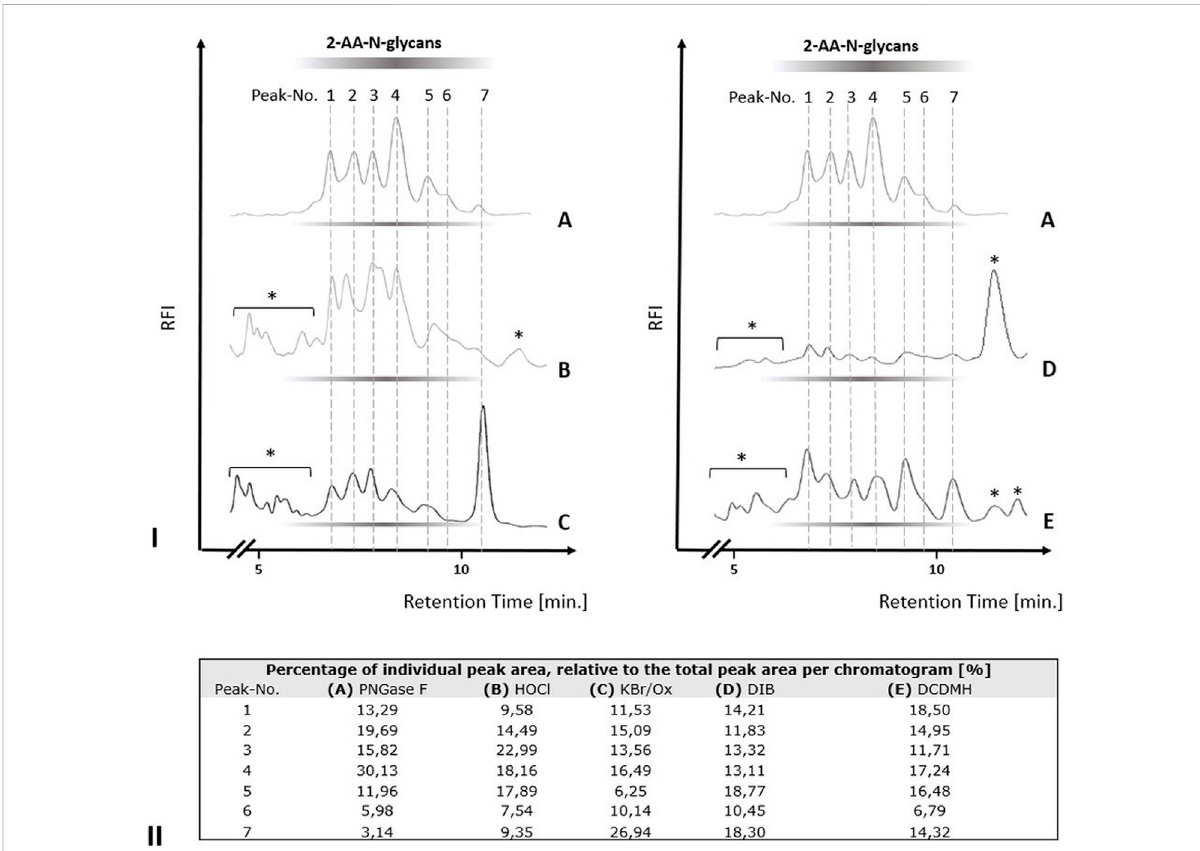
FIGURE 4 N-glycan release from chicken ovalbumin caused by different chemical effectors of the Hofmann carboxamide rearrangement. I. RP-HPLC- FLD peak pro fi les for the respective 2-AA-labeled N-glycan samples obtained by enzymatic or by the different chemical methods: (A) : Positive control, PNGase F released 2-AA- N-glycans, (B) : Hypochlorite released 2-AA-N-glycans, (C) : Bromide/Oxone released 2-AA-N-glycans, (D) : Diacetoxy-iodobenzene (DIB) released 2-AA-N-glycans, (E) : 1,3-dichloro-5,5-dimehylhydantoin (DCDMH) released 2-AA-N-glycans. Asterisks:non-glycanartifacts.RP-HPLC-FLDconditions:column:OTUTriKalaC18150×3 mm,isocraticsolvent:10%Acetonitrile/0.1%formicacid, λ fl ow rate: 0.5 ml/min., column temperature: 25 ° C, λ ex = 360 nm, em = 420 nm; GAIN 100. II. Percentages of individual peak area for each chromatogram of Figure 4I, relative to the total peak area per each chromatogram